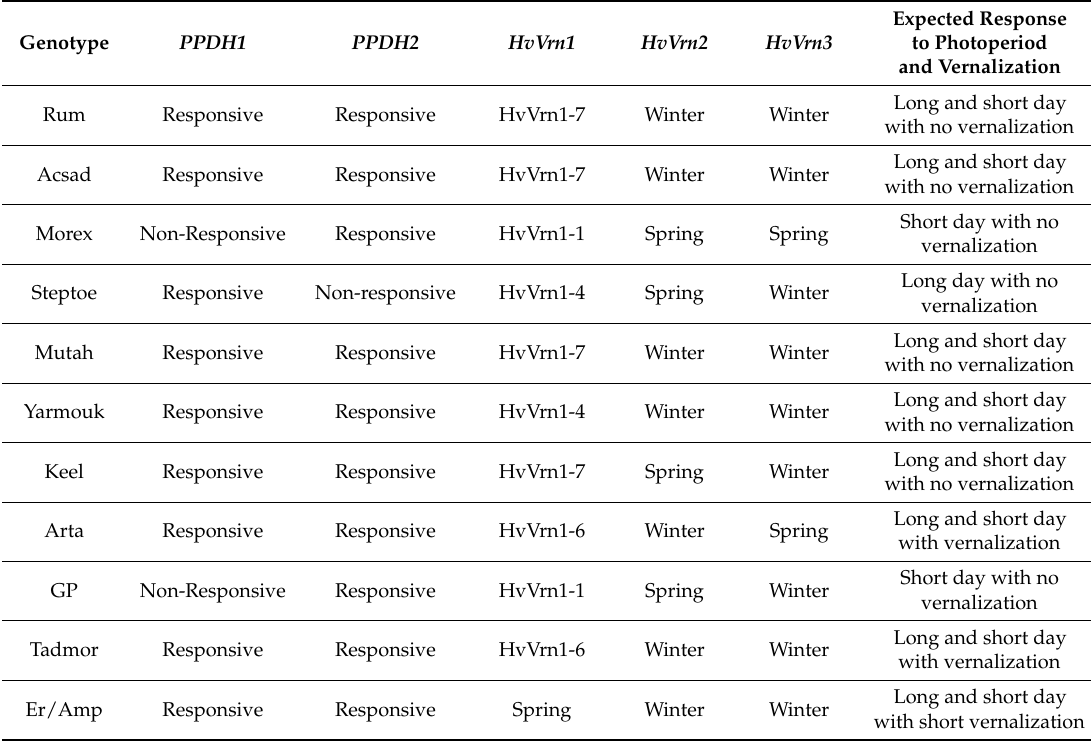
Table 2. Allelic variation of five major FTi genes in 11 different barley genotypes as assayed by using diagnostic markers (based on Drosse et al . (2014) [20]).